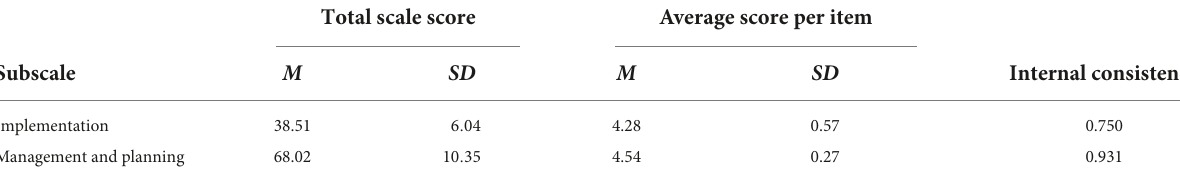
TABLE 2 Descriptive statistics and internal consistency coefficients for the confidence